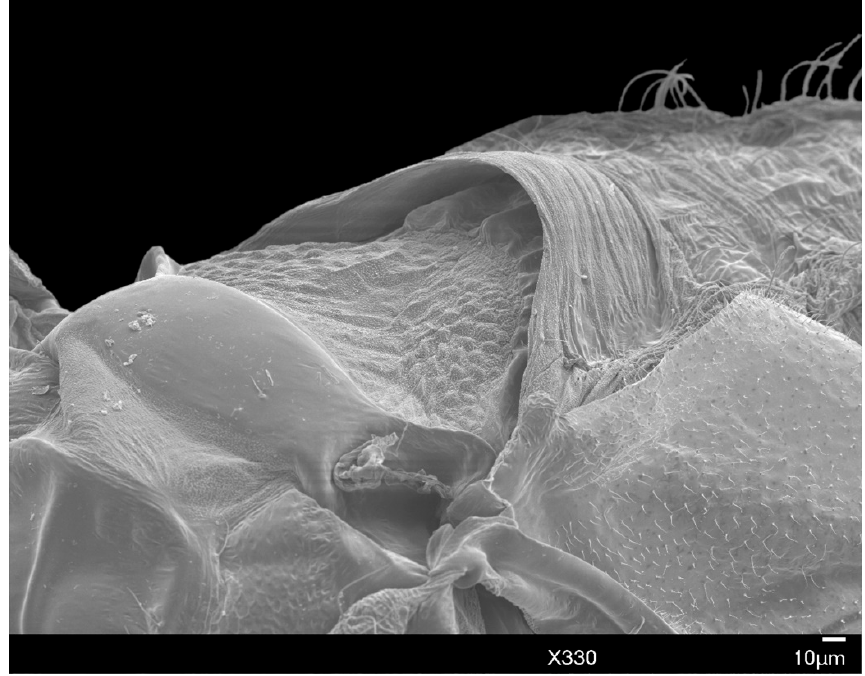
Figure 10. SEM prescutum and raised prescutal ridge of male A. galliformis.